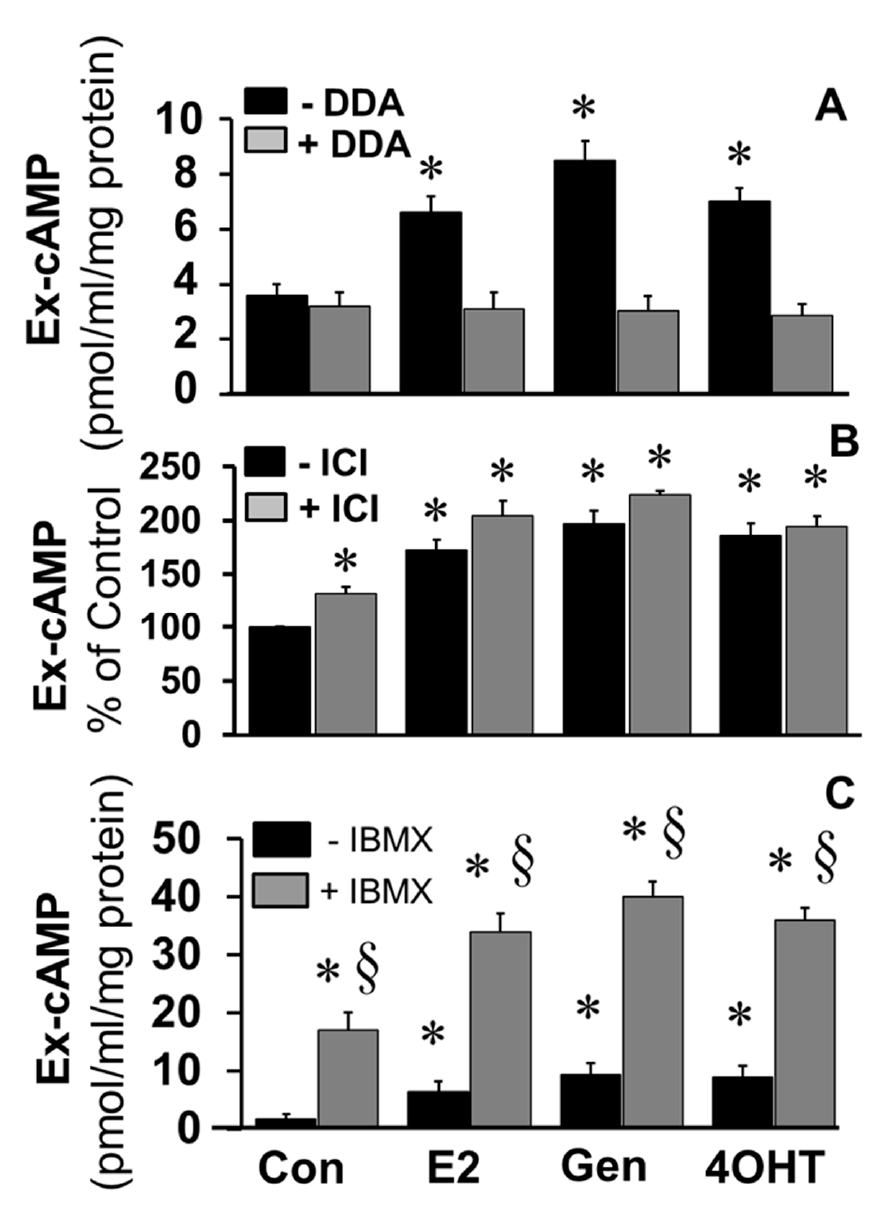
Figure 5. Bar graphs depicting the effects of 17 β -estradiol (E2; 20 ng/mL), genistein (Gen; 20 ng/mL) and 4OH-TCB (4OHT; 20 ng/mL) on extracellular (Ex) cAMP production by FTCs stimulated for 15 min in absence or presence of: Panel ( A ) the transmembrane adenylyl cyclase inhibitor 2 ′ 5 ′ -dideoxyadenosine (DDA; 10 μ M); Panel ( B ) the estrogen receptor- αβ antagonist, ICI182780 (ICI; 1 μ M); and Panel ( C ) the PDE inhibitor IBMX (1 μ M). Data (mean ± SEM) represent the mean of three different experiments ( n = 3) in triplicates. Values were normalized to total protein concentration and the cAMP levels are expressed as pmol/mL/mg protein or percent of control. * p < 0.05 vs. respective control; § p < 0.05 vs. treatment in absence of IBMX).